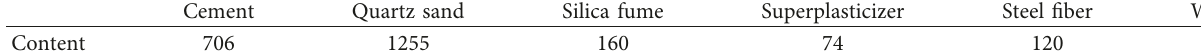
Table 4: The standard mix ratio of UHPFRC (unit: kg/m 3 ).